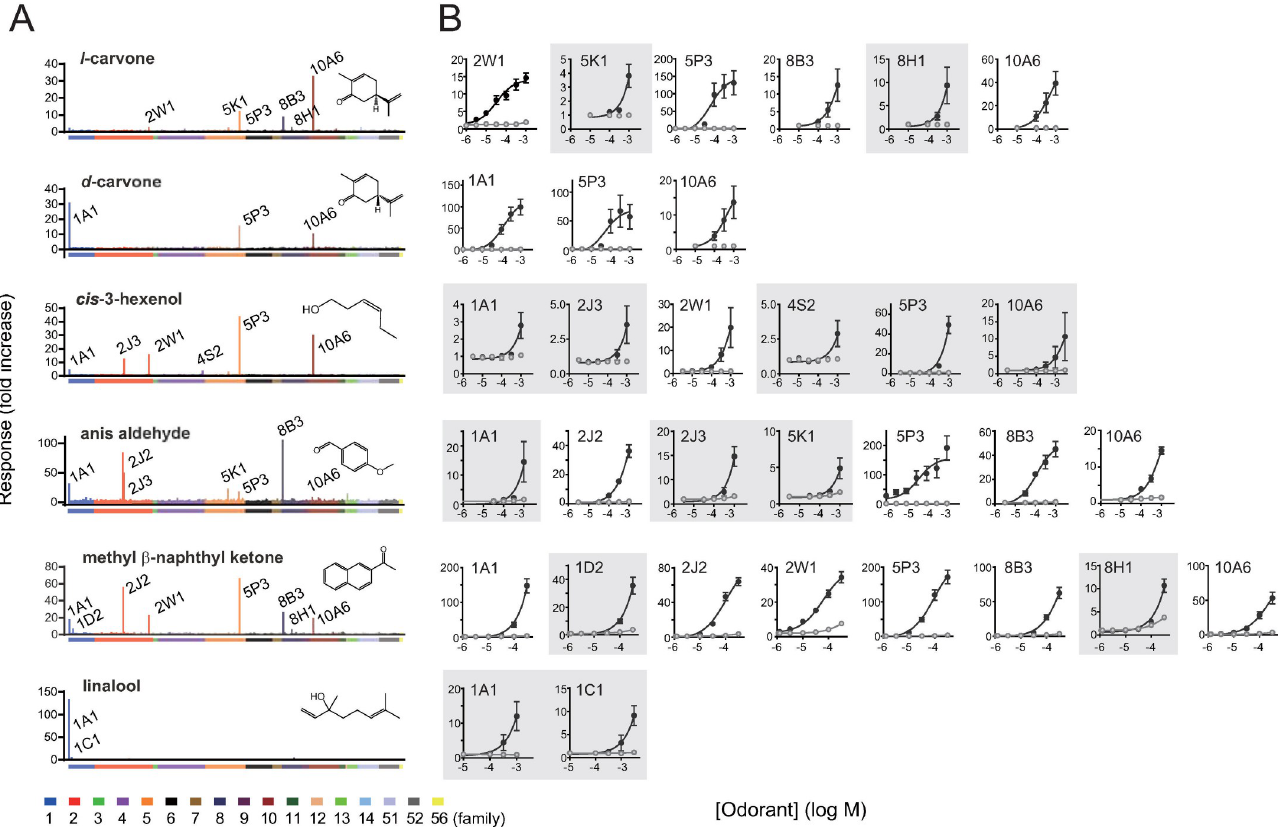
Fig 1. HEK293 cell-based screening of human ORs for six perfumery raw materials. A. Primary screening of human ORs using 384-well plates. 378 ORs were expressed in HEK293 cells, and they were stimulated with a single concentration of each odorant. HEK293 cells were co-transfected with each OR, CRE/ luc2PpGL4.29, pRL-CMV, and RTP1S. Odorant solutions were diluted in the growth medium without FBS. X-axis lists each of the 378 ORs, and color bars represent OR families. Y-axis indicates the response of cells expressing each OR as fold increase where a signal from stimulated cells was divided by that from non- stimulated cells expressing the same OR (mean values from two screening replicates). B. Verification of dose-dependent responsiveness of cell-expressing candidate ORs using 96-well plates. Each OR was co-transfected with CRE/luc2PpGL4.29, pRL-CMV, and RTP1S. 32 pairs of ORs and their agonists that meet our statistical criteria for dose-dependent responses are shown. The grey-shaded ORs do not fit a sigmoidal curve because their responses were not saturated in the range of concentrations tested due to less sensitivity. Y-axis indicates the fold increase value, and data are shown as mean ± SE from three independent experiments.